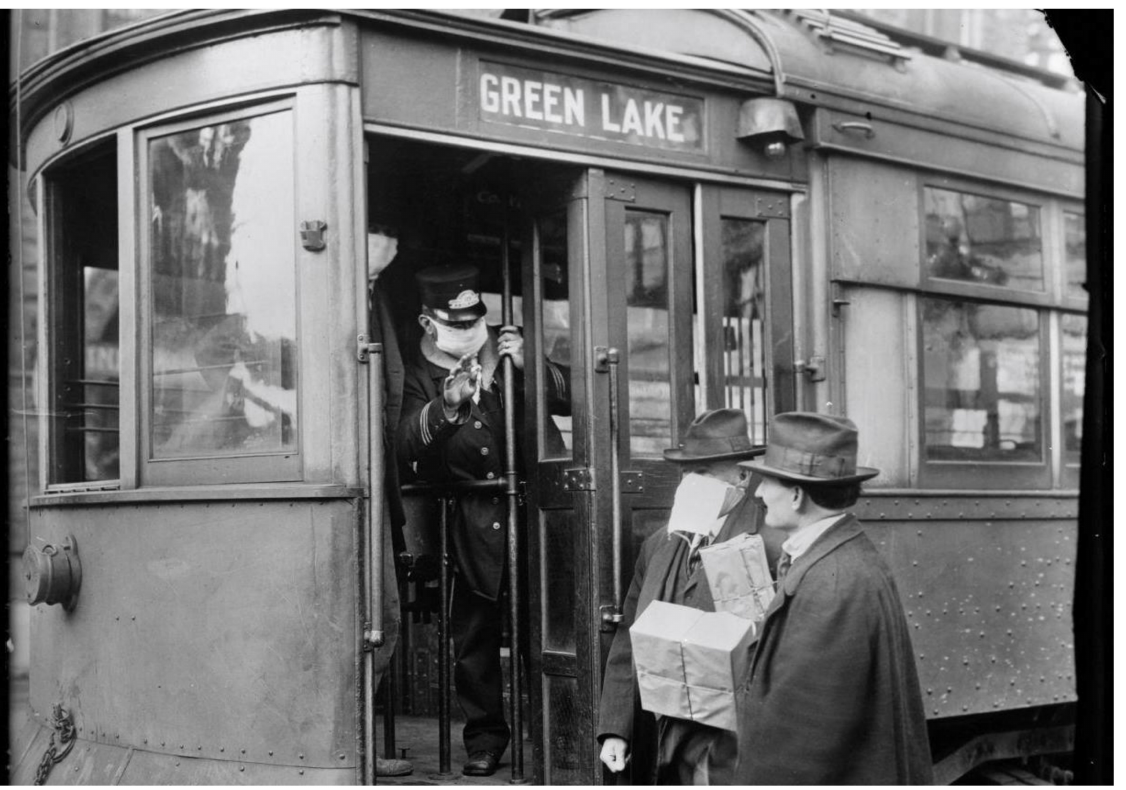
Figure 1. Seattle (Washington) streetcar conductor checks passenger face masks during the 1918 influenza pandemic (source: Library of Congress)